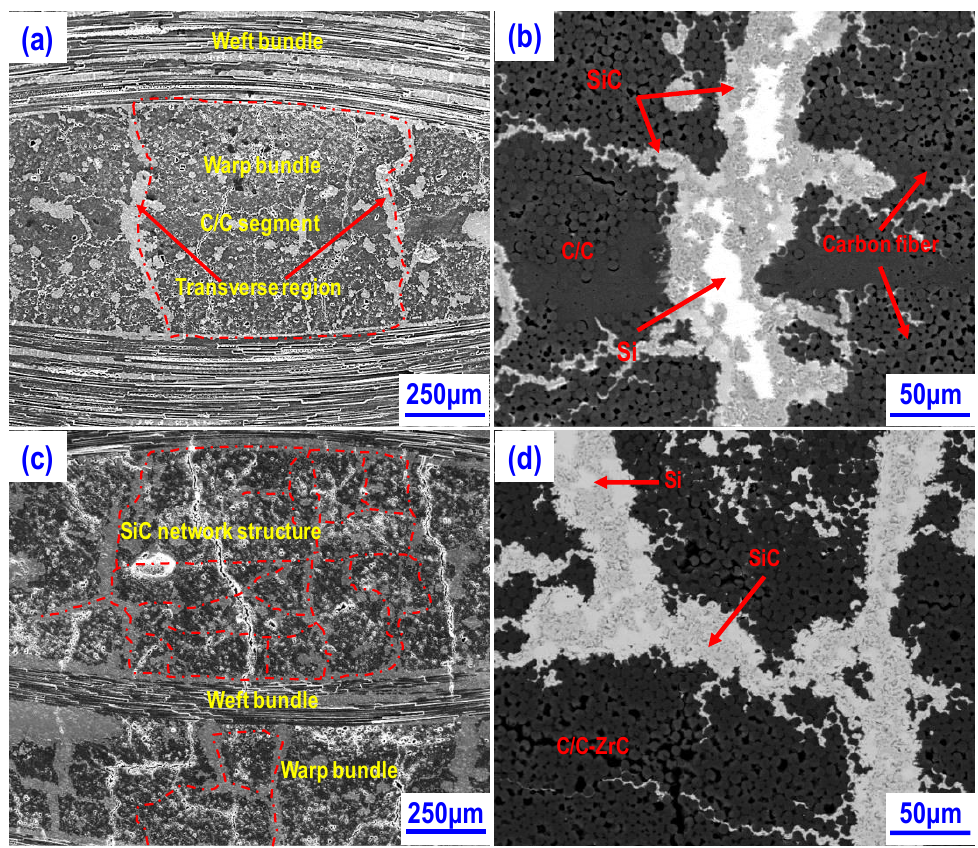
Figure 4. Polished surface morphologies of final ceramic composites: ( a ) SEM cross-section image for CSZ0; ( b ) BSE image for CSZ0 from the selected area in ( a ); ( c ) SEM cross-section image for CSZ10; ( d ) BSE image for CSZ10 from the selected area in ( c ).